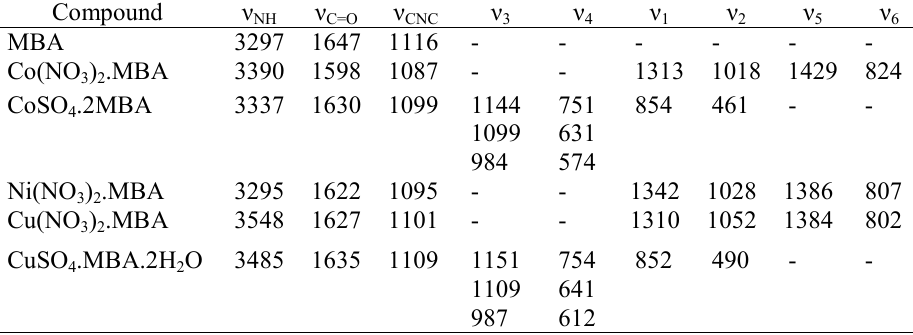
Table 2. Important IR Absorption Bands (cm -1 ) of MBA and of Co II , Ni II , and Cu II